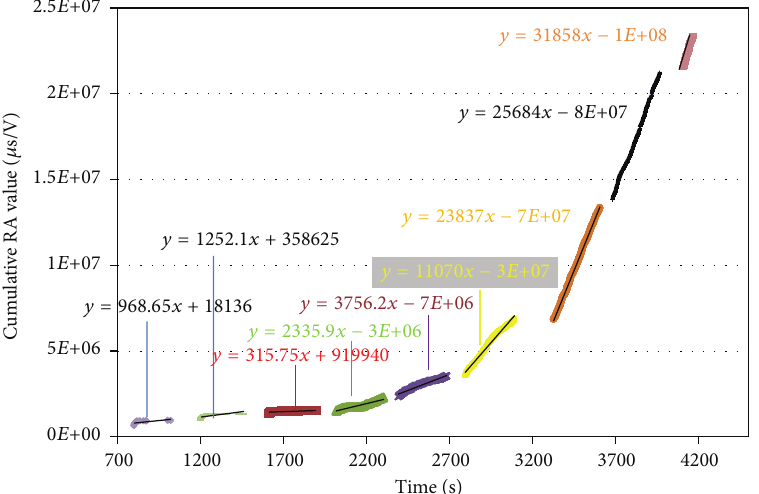
Figure 14: Cumulative RA value for the different fatigue loading stages.